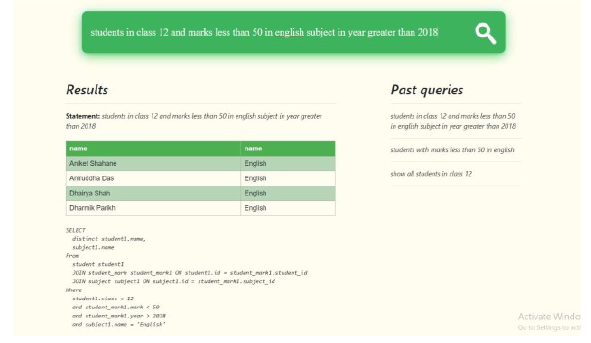
Figure 4. Generated Output